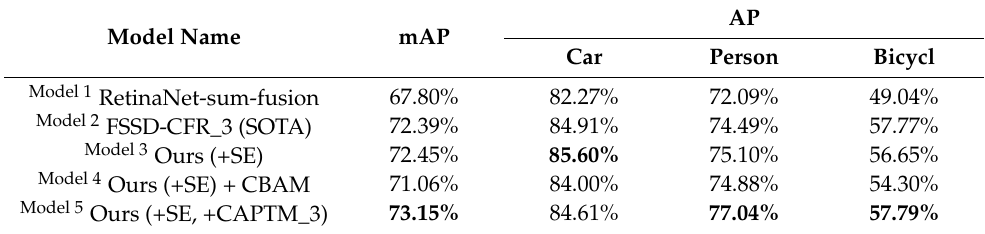
Table 6. Results of different